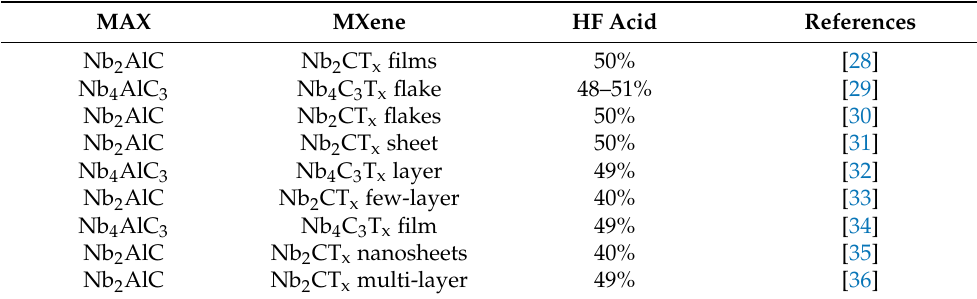
Table 1. Using direct HF, several etching techniques were used to create Nb 2 CT x and Nb 4 C 3 T x